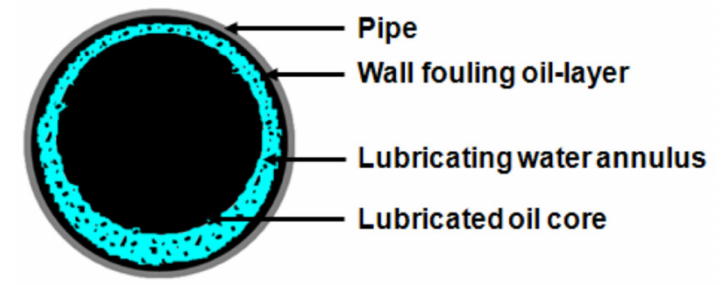
Figure 1. Schematic presentation of water-assisted flow regime